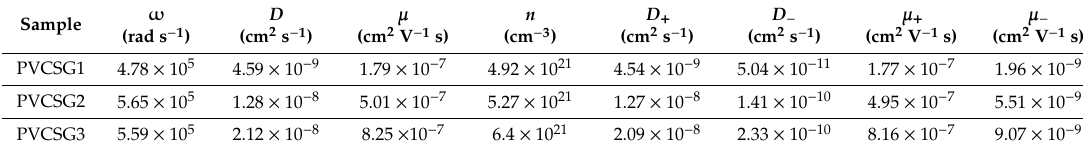
Table 3. Values of ω and ion transport parameters at room